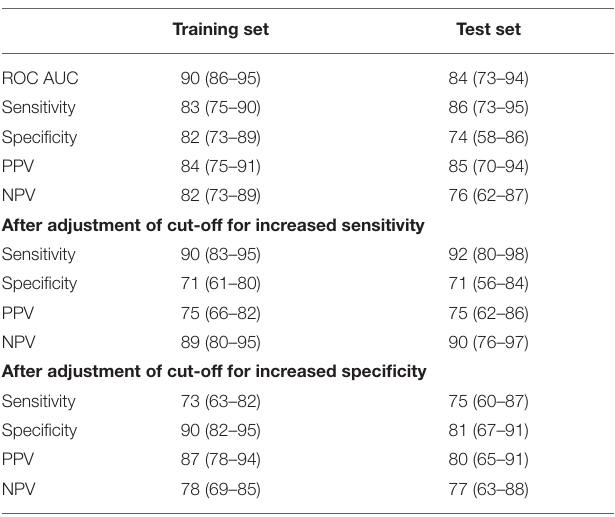
TABLE 8 | Performance of a nine-protein signature derived from Parallel Regularised Regression Model